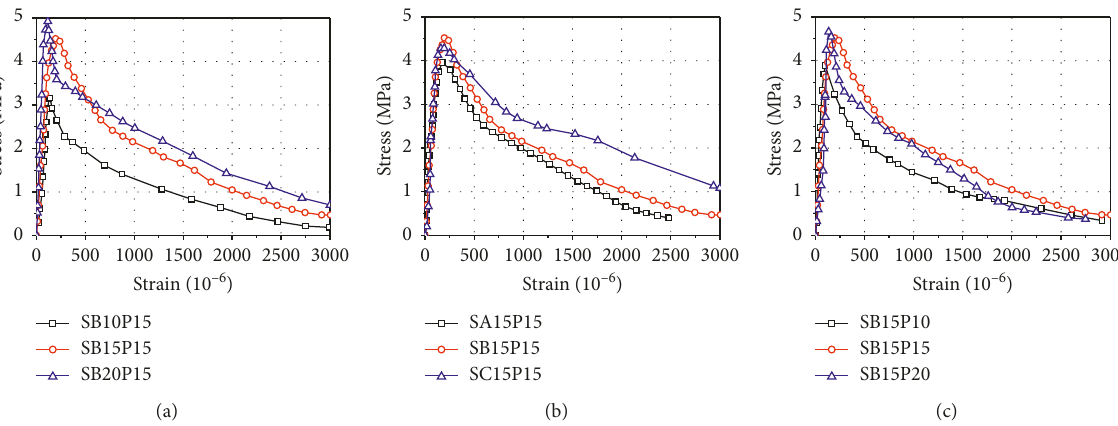
Figure 7: Envelope curves of HFRC under cyclic tension: (a) effect of volume fraction of SF; (b) effect of aspect ratio of SF; (c) effect of volume fraction of PF.